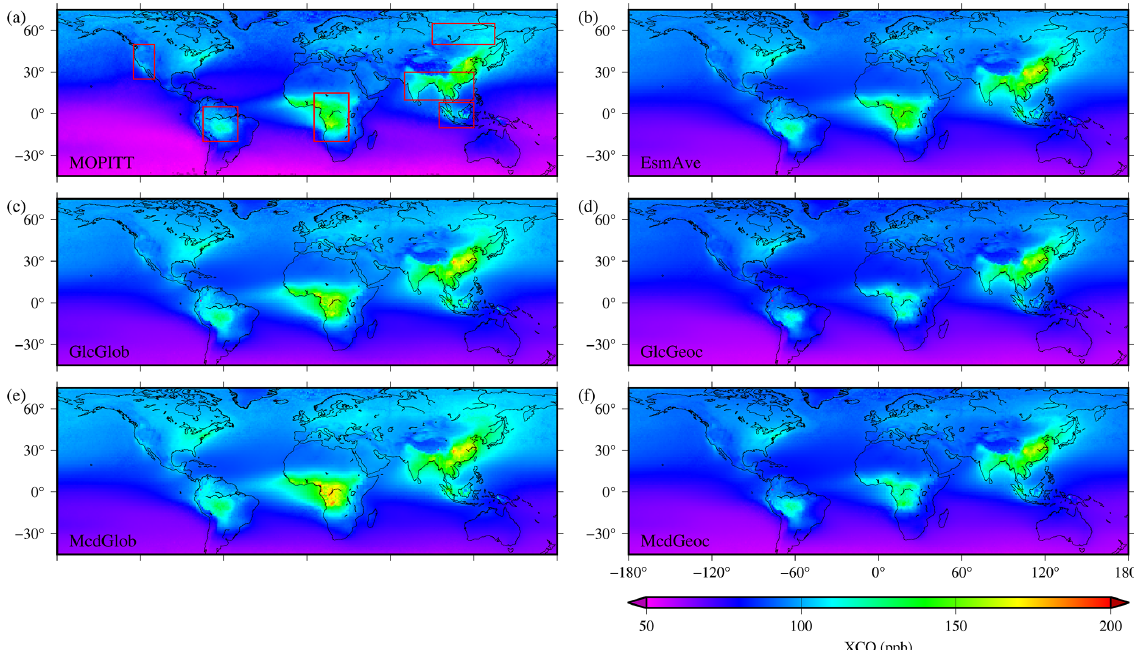
Figure 6. Spatial distributions of mean XCO (ppb) between 2013 and 2015 for (a) MOPITT level 3 product and the simulations using